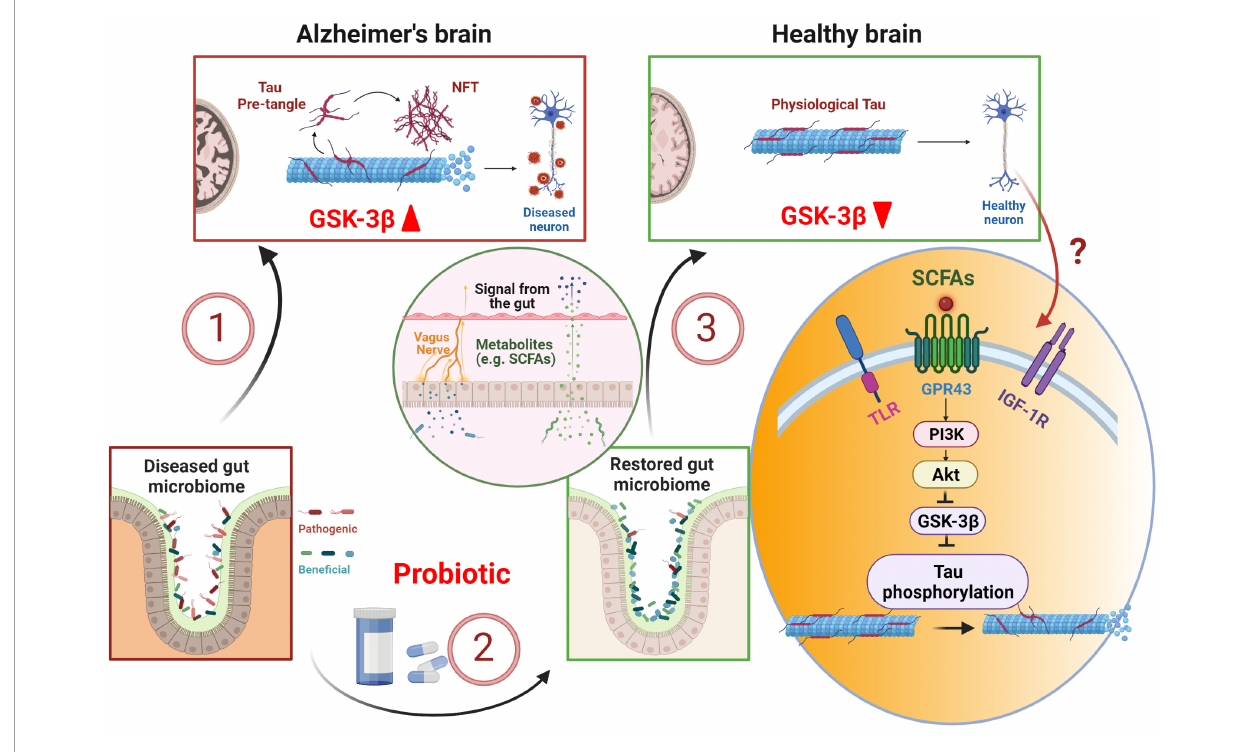
FIGURE1 Probiotic therapy in early tau pathology prevention and treatment. Alzheimer’s disease is associated with dysbiosis in the gut, which in turn, can exacerbate tau pathology leading to tau hyperphosphorylation via GSK-3 β pathway (1) . Probiotic supplement restores gut microbiome (2) , stimulates the release and transport of short-chain fatty acids (SCFAs) into the brain via enteric nerves and blood stream (3) . SCFAs stimulate PI3K/Akt pathway and down-regulates GSK-3 β , thus preventing tau hyperphosphorylation. NFT, neurofibrillary tangle; TLR, Toll-like receptor; IGF-1R, insulin-like growth factor 1 receptor. Created with